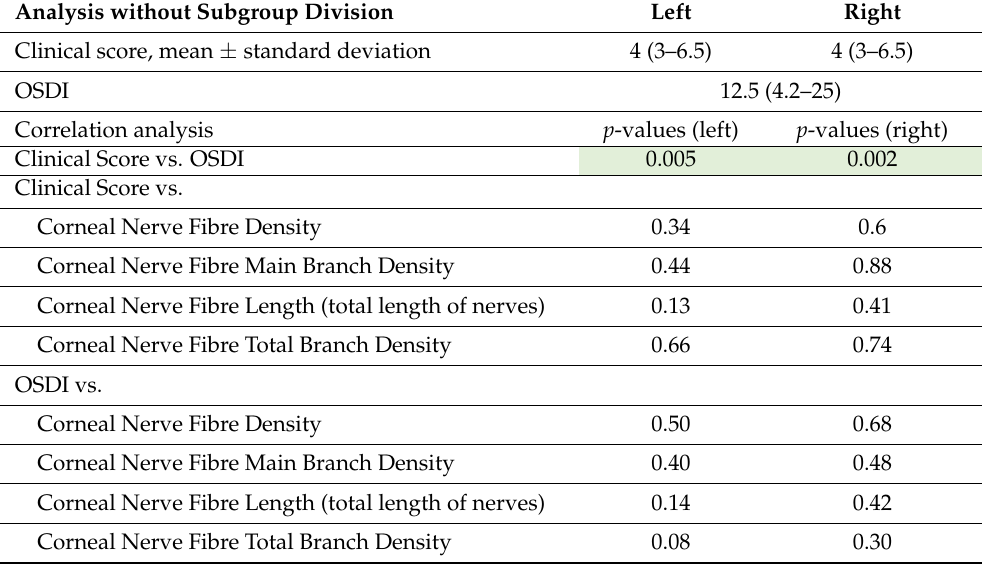
Table 4. Correlation analysis for the full cohort between parameters of the corneal confocal micros- copy and the clinical evaluation of dry eye symptoms and signs with significance levels (green color- significant group differences).